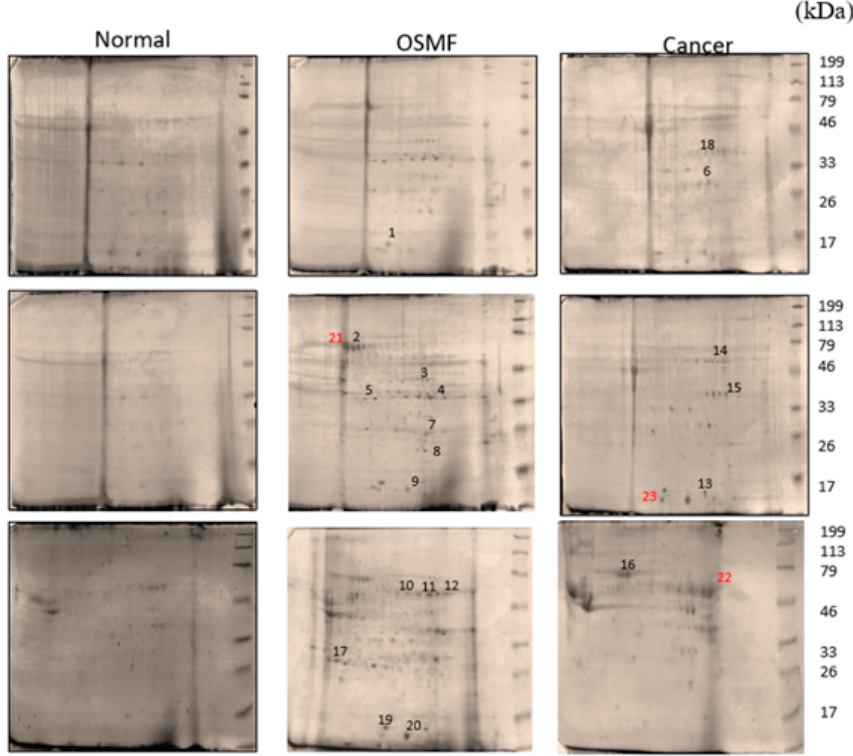
Figure 1. Representative 2DE gel images of normal, OSMF and OSCC tissue samples. 197 Table 1. List of upregulated proteins between OSMF, OSCC and normal tissues identified using MALDI ‐ TOF. 198 Spot Gene ID Accession ID